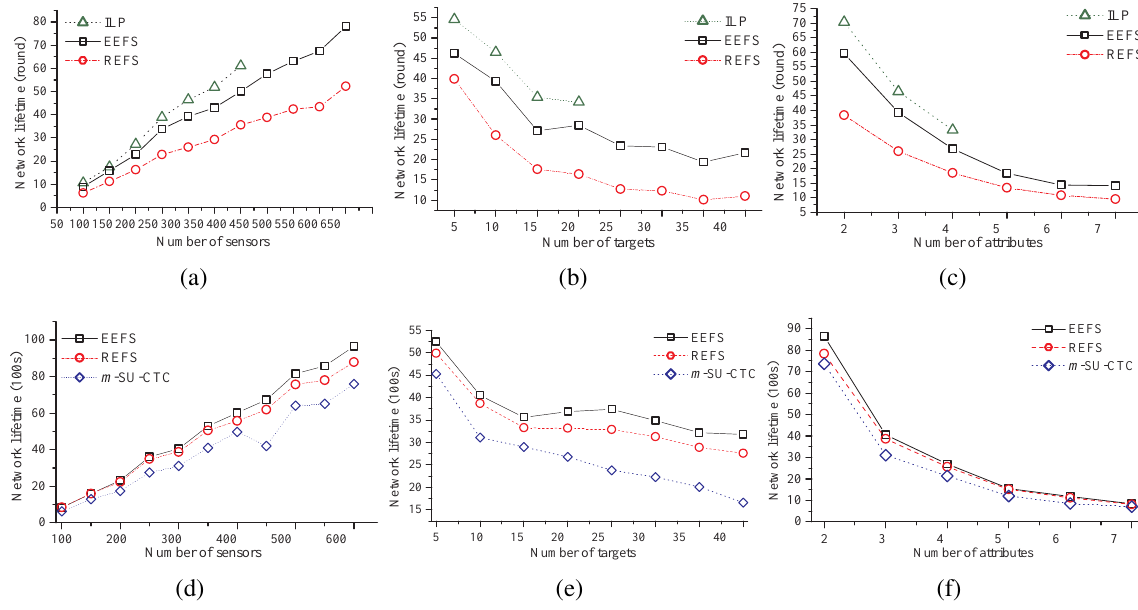
Figure 7. The impacts of the numbers of (a) sensors, (b) targets, and (c) attributes in sce- nario1 as well as (d) sensors, (e) targets, and (f) attributes in scenario 2 on the network